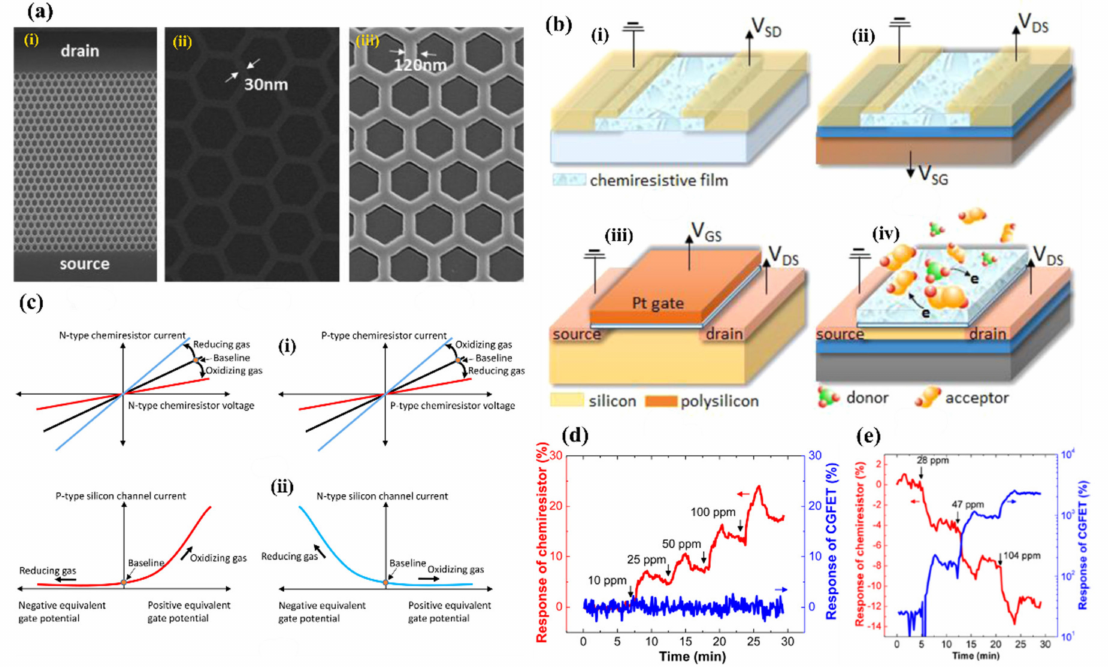
Figure 21. ( a ) SEM images of the ( i ) fabricated SnO 2 CGFET, ( ii ) close-up view of the honeycomb channel region before and ( iii ) after the SnO 2 deposition process, ( b ) schematic illustration of various gas sensor structures: ( i ) two terminal chemiresistor, ( ii ) back-gated FET, ( iii ) platinum gate FET typically used as hydrogen sensors, and ( iv ) metal-oxide floating gate CGFET. ( c ) Conceptual illustration of the response of ( i ) chemiresistor and ( ii ) CGFET for oxidizing and reducing gases. The monotonic function of the chemiresistor results in a response to both oxidizing and reducing gases. The nonlinearity of the normally o ff CGFET selectively responds to the corresponding type of gas. The response of the CGFET and the control chemiresistor with di ff erent concentration for ( d ) ammonia and ( e ) O 2. Reproduced from [161], with permission from American Chemical Society,